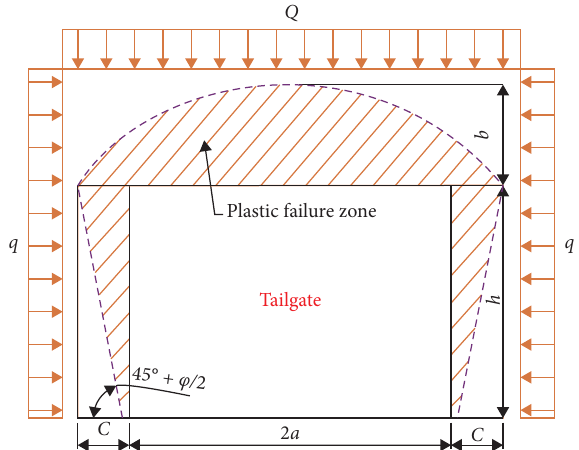
Figure 4: Calculation chart of surrounding rock damage range of roadway.